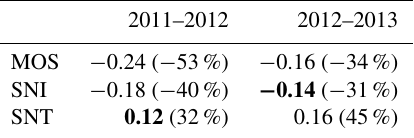
Table 4. Mean absolute error (mm) between bulk grain diameter simulated with the microstructure models compared with observa- tions derived from SSA measurements with IceCube. Smallest bias for each year is shown in bold. Percentages are given in parentheses.